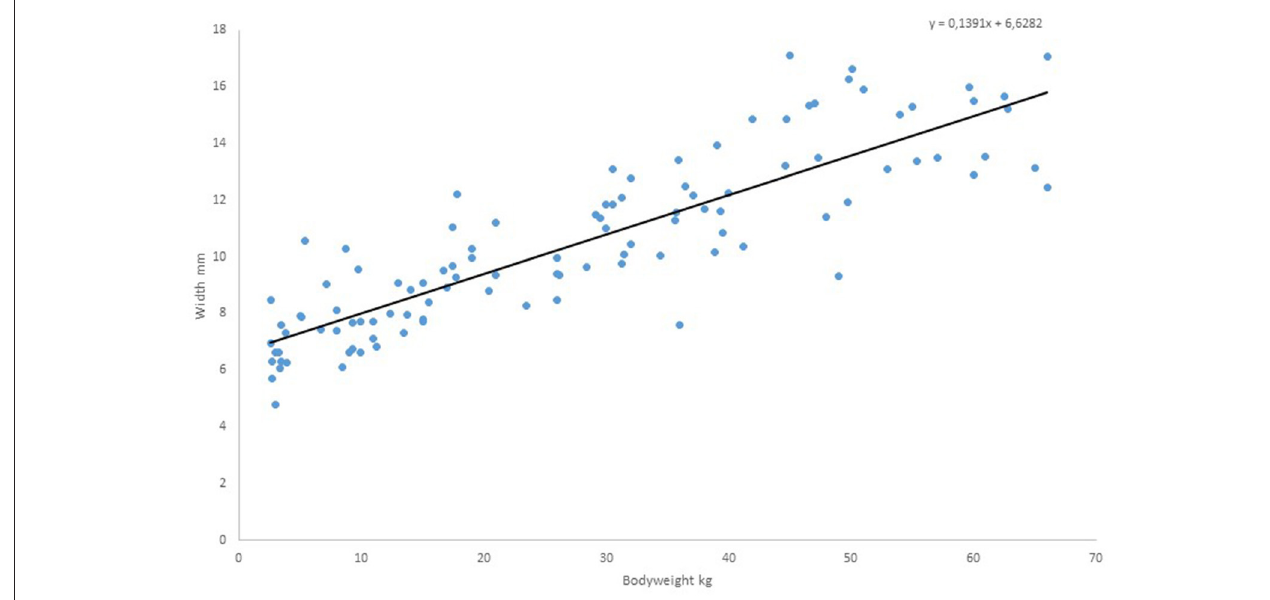
FIGURE 2 | Measured values of diameter of the esophagus as a function of body weight, upper measuring point.